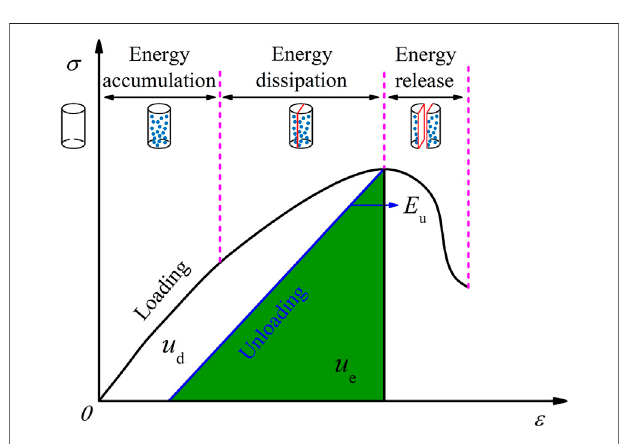
FIGURE 2 | Energy evolution process of